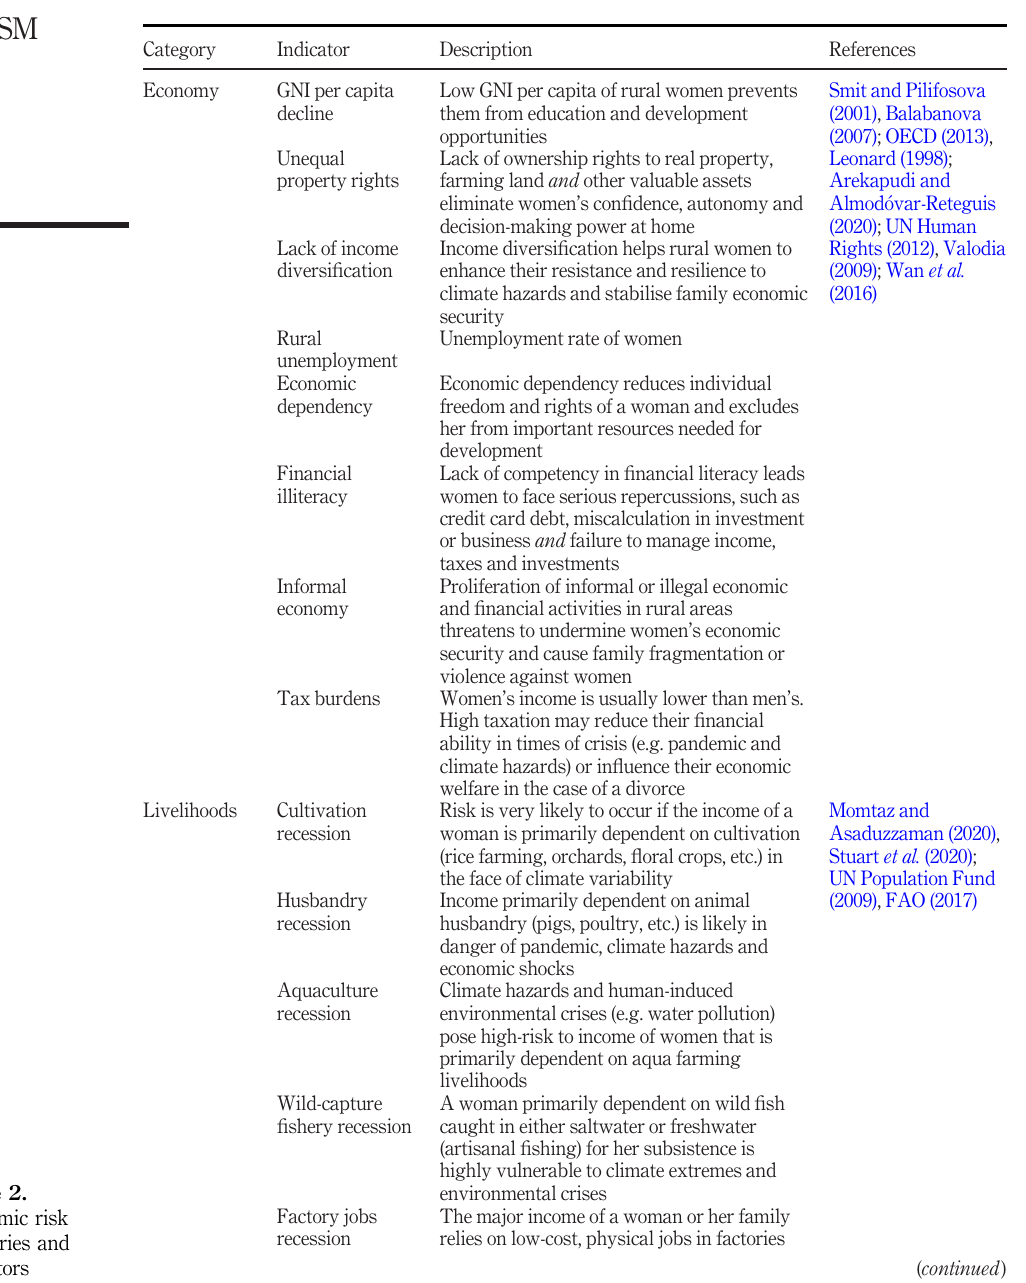
Table 2. Economic risk categories and